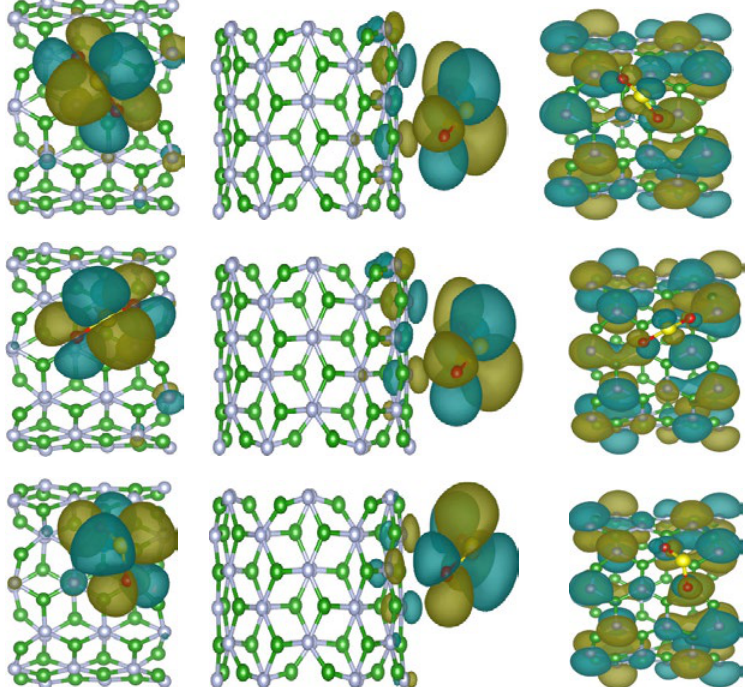
adsorbed BN nanotubes. 2